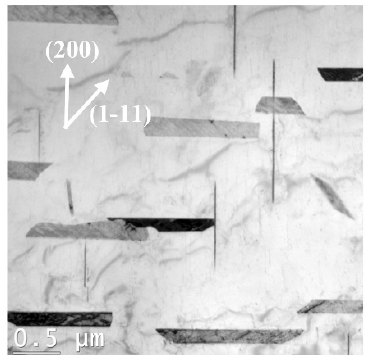
Figure 10. TEM observations on a binary Al-3.5 wt%Cu alloy aged 1 h at 350 °C along the axis <011> in g200 beam condition.